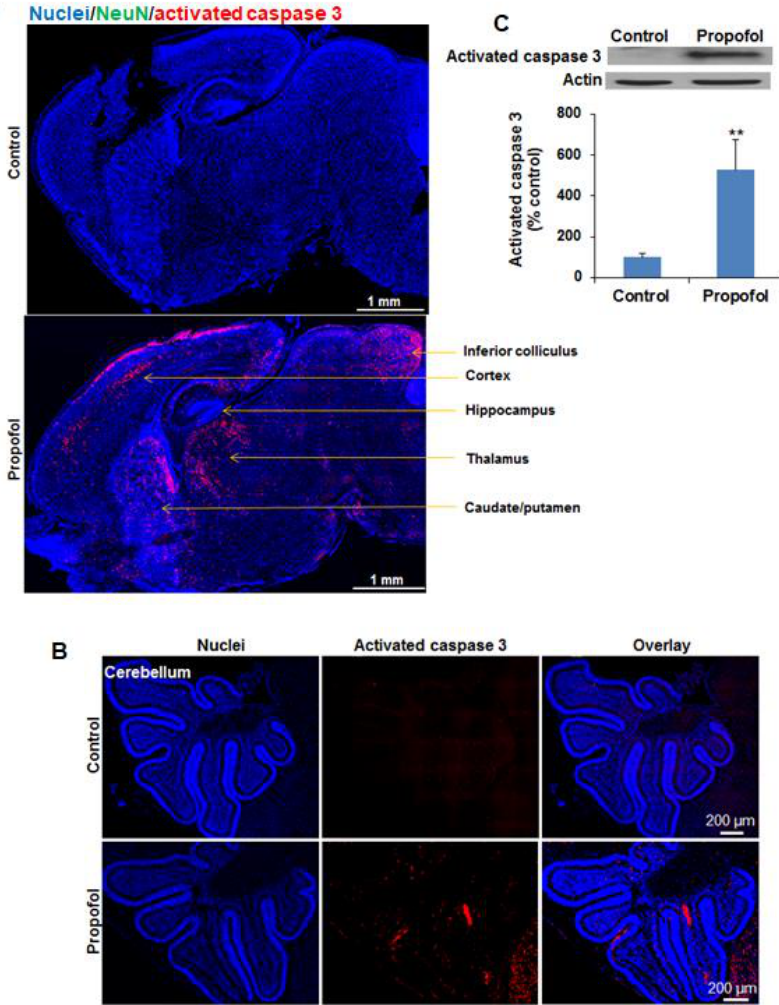
Figure 1. Propofol exposure induces widespread apoptotic cell death in neonatal mouse brains in a region-specific manner. Seven-day-old mice intraperitoneally received propofol (50 mg/kg body weight) or 10% intralipid as a vehicle control for 6 h. ( A , B ) The fluorescence images of immunostained sagittal section of mouse brains show that several brain regions such as cerebral cortex, caudate/putamen, thalamus, hippocampus, subiculum, entorhinal cortex, inferior colliculus, and cerebellum are more vulnerable to propofol than other regions as evidenced by the higher density of apoptotic cells observed in these regions. Blue are cell nuclei stained with Hoechst 33343 and red are activated caspase 3–positive apoptotic cells; ( C ) Western blot analysis demonstrated that the activated caspase 3 level was significantly increased in the propofol-treated brains (527.68 ± 146.39% control group). Scale bars = 1 mm ( A ) and 200 µm ( B ); ** p < 0.01.